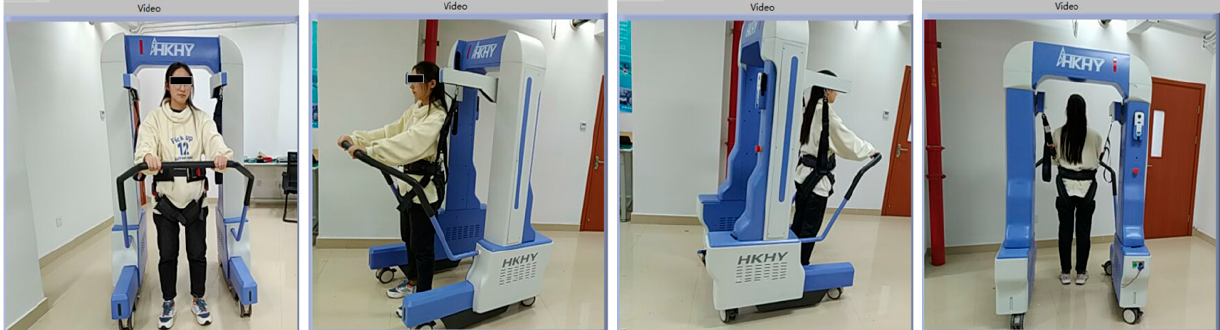
Figure 17. Video communication acquisition test of the remote system.